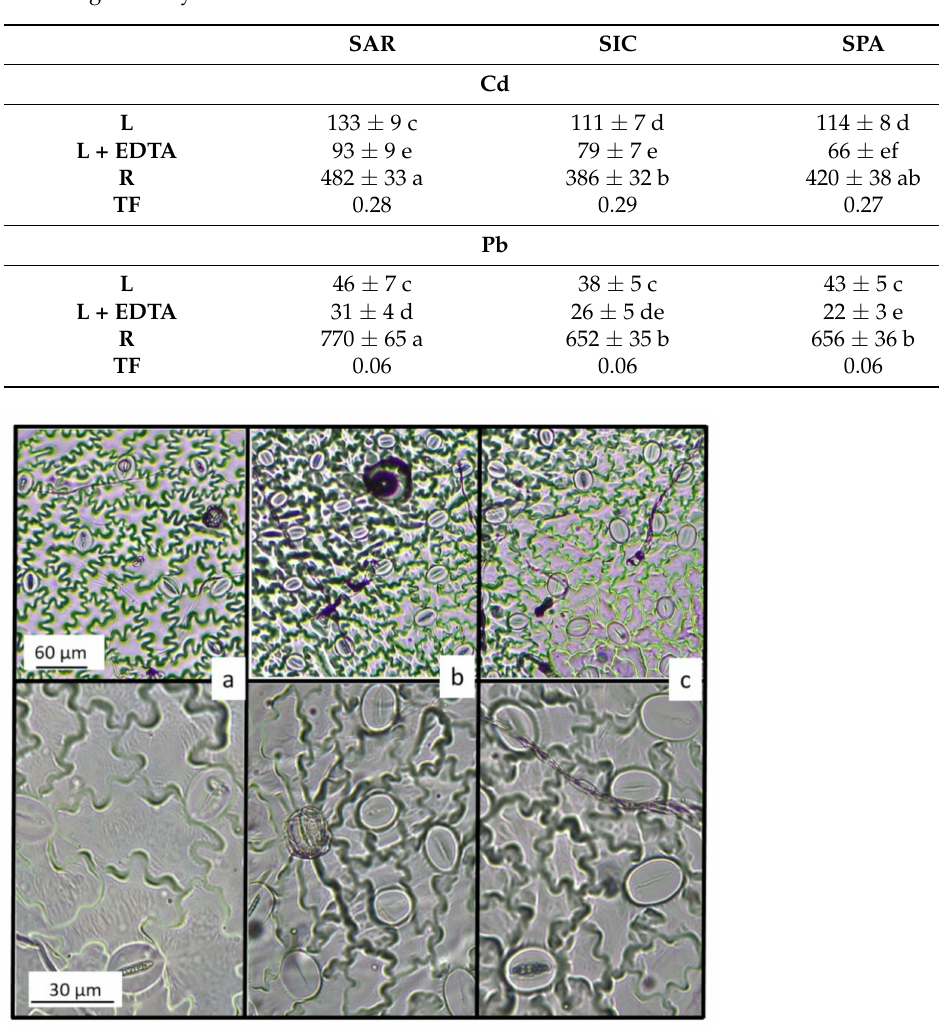
Figure 2. Leaf abaxial surface of C. cardunculus cv. Spagnolo; ( a ) control; ( b ) Cd-treated sample; ( c ) Pb-treated